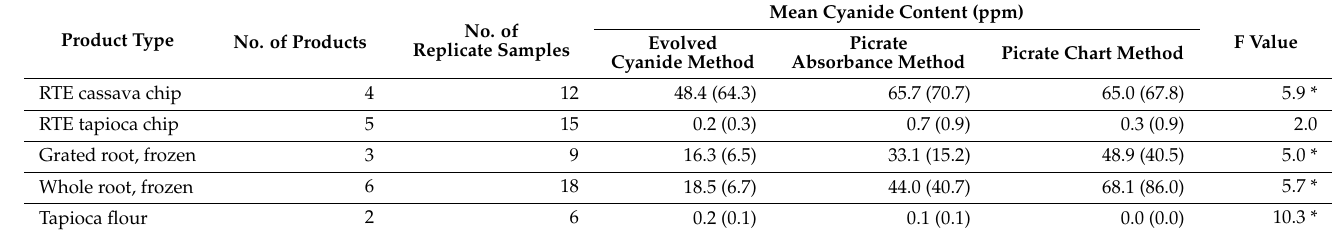
Figure 1. Total cyanide content of cassava products as determined by the evolved cyanide, picrate absorbance and picrate chart methods. All replicates are shown, with group means represented by the black lines. Within product types, differences among cyanide content measurements using the different methods were analysed by one-way ANOVA: * p < 0.05; ns = not significant. Table 1. Total cyanide content (ppm) from the cassava-containing products determined by three different methods. Mean (SD) values were calculated using all observations of each product type. Within product types, differences among cyanide content measurements using the different methods were analysed by one-way ANOVA, with F values presented. Asterisks depict significant F values ( p <